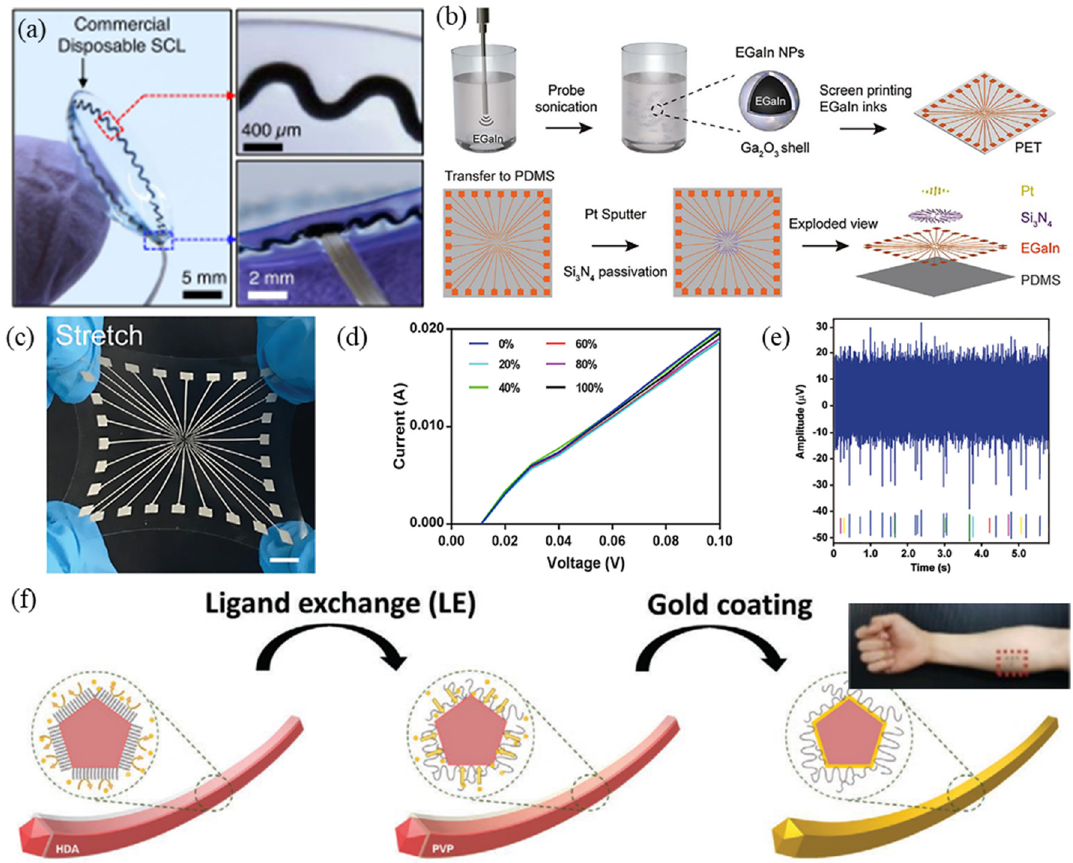
Figure 2. Summary of preparation strategies for flexible electrical physiology electrodes. ( a ) Photographs of a corneal sensor with inset images highlighting the serpentine layout and its seamless integration with the connection wire. Reproduced with permission from [38]. Copyright 2021, The Authors. ( b ) Schematic illustration of the fabrication of a stretchable electrode array (SEA). ( c ) Snapshots of a SEA with high flexibility and stretchability. ( d ) I–V curves of the conductive trace with different strains. ( e ) In vitro neural signal recording by the SEA (1 Hz to 3 kHz; noise floor: − 20 μ V). ( b – e ) are reproduced with permission from [41]. Copyright 2021, John Wiley and Sons. ( f ) Schematic of the gold deposition process for an electrical physiology (EP) electrode. Reproduced with permission from [42] Copyright 2020, John Wiley and Sons.